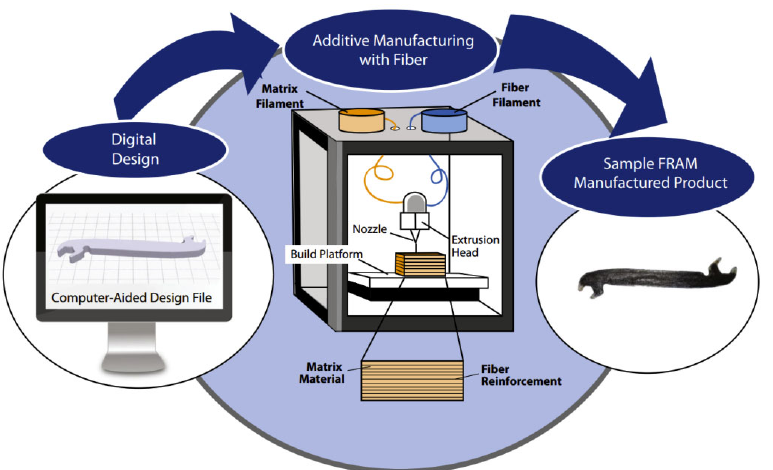
Fig. 42 Schematic layout of continuous fiber reinforced polymer matrix composites. Reproduced with permission from Ref. [111], © Springer-Verlag London Ltd., part of Springer Nature